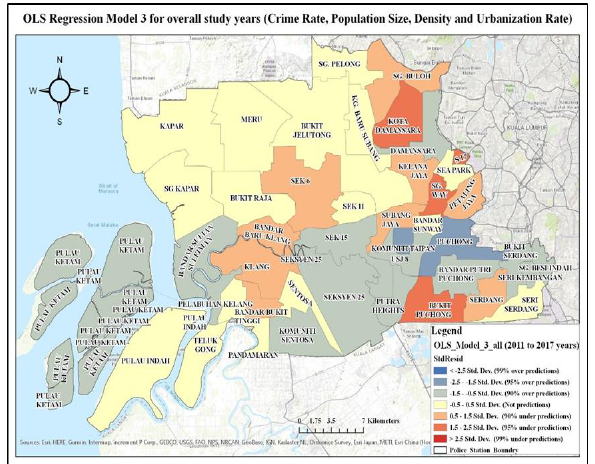
Figure 9: OLS spatial regression result residual